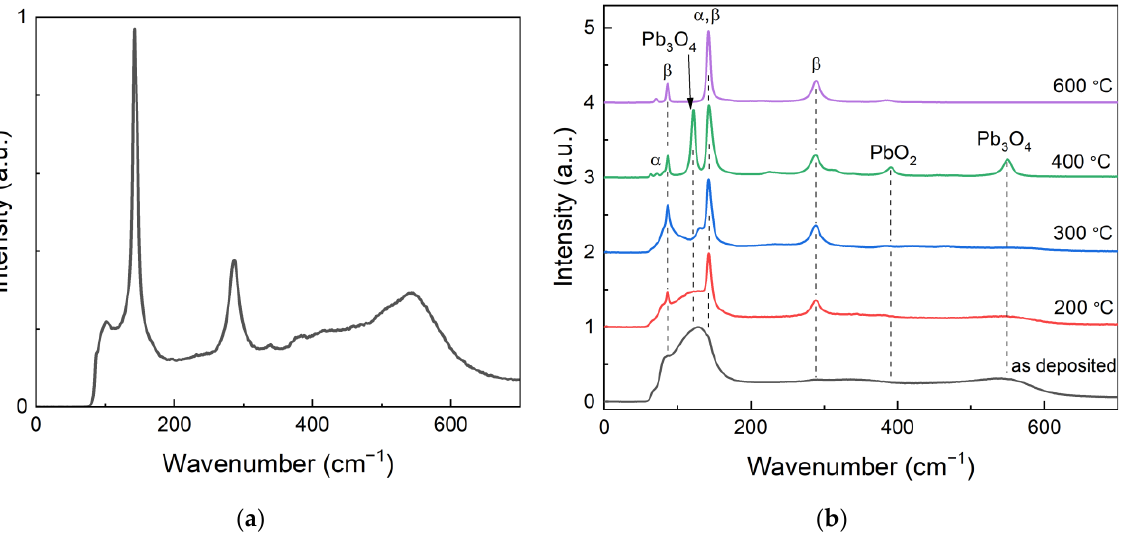
Figure 9. Raman spectra of ( a ) as-deposited thick a-PbO layer discussed in this work and ( b ) thin a-PbO layer annealed at different temperatures. The spectrum of the as-grown thick layer demonstrates the same characteristic features of thin a-PbO annealed at the temperature of 200 °C. ( b ) Image adapted from Semeniuk et al. [25] with the permission of Springer Nature.